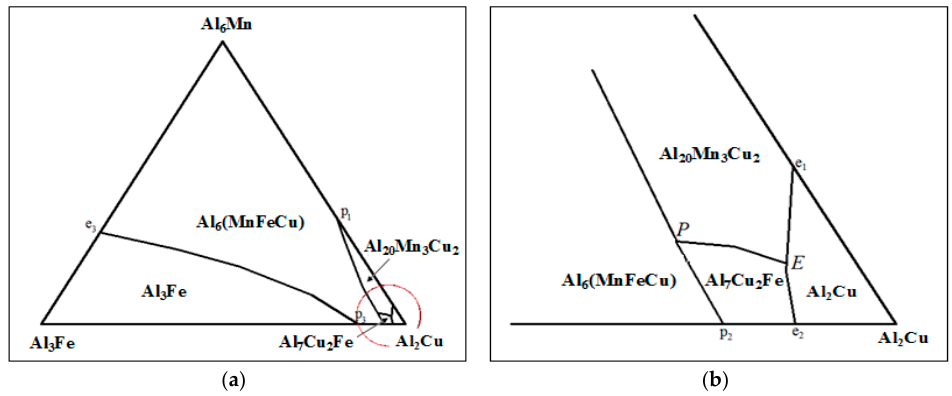
Figure 11. Phase diagram of intermetallics Al-Cu-Fe-Mn system alloy: ( a ) Polythermal projection of the solidification face in the Al corner; ( b ) enlarged view in the Al 2 Cu side.